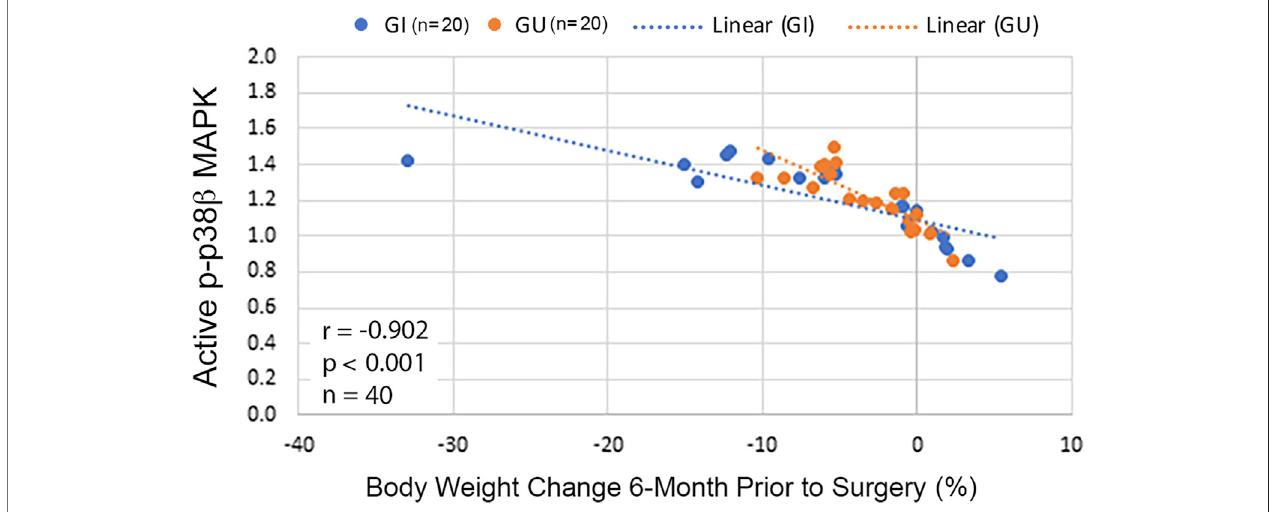
FIGURE5| Activityofp38 β MAPKinRAcorrelateswithbodyweightchangeincancerpatients.Scatterplotswithlinesofbest fi t(dottedline)weredrawnseparately for cancer patients with GI or GU cancer displaying association between p-p38 β MAPK level and relative body weight change 6-month prior to surgery. Correlation was analyzed with Spearman correlation for all patients (shown in the fi gure) and separately for GI ( r (cid:1) − 0.91, p < 0.001, n (cid:1) 20) or GU cancer ( r (cid:1) − 0.84, p < 0.001, n (cid:1) 20).